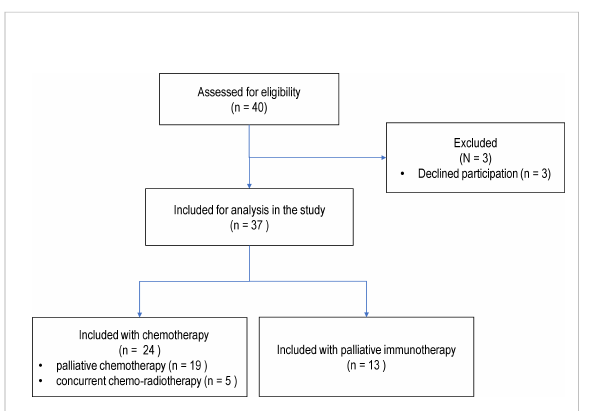
FIGURE 2 Swimmers Plot displaying timelines for all patients from admission (day 0) until 1-year follow up or death. The following events are displayed: Blood samples (grey triangles), radiotherapy (red diamonds), Glucocorticoids (blue diamonds) and death (grey X). Patients are grouped according to treatment (chemotherapy (CT), concurrent chemo- and radiotherapy (CRT) and immunotherapy